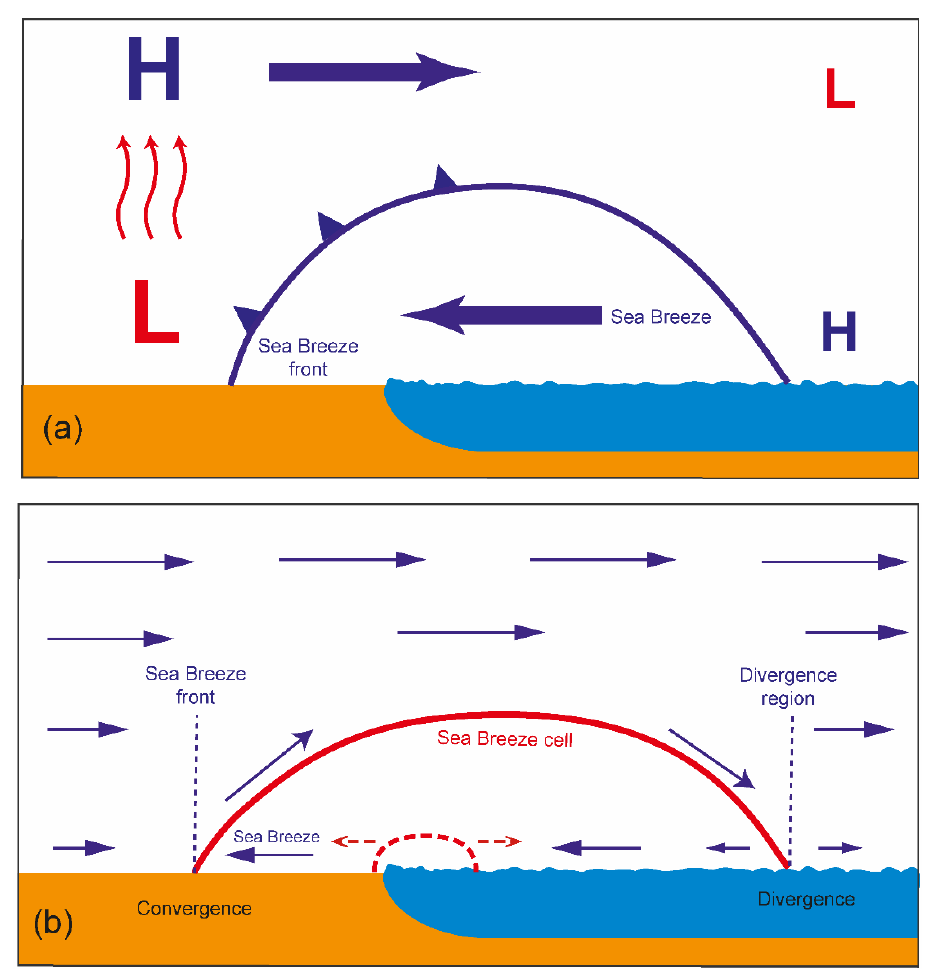
Figure 1. ( a ) Schematic of the sea breeze circulation perpendicular to the coast showing the sea breeze front propagating on land and the distribution of pressure. Here, the synoptic winds blow in an offshore direction; ( b ) schematic of the sea breeze cell showing areas of convergence and divergence. The sea breeze cell initially forms over the ocean (dashed red line) and propagates both onshore and offshore (solid red line).